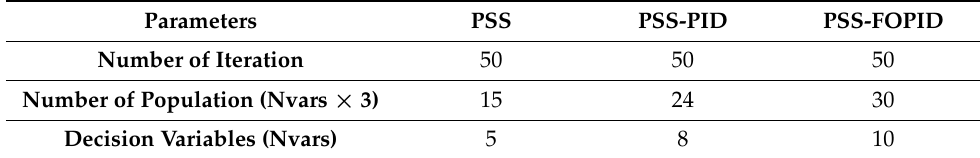
Table 1. Algorithm parameters.